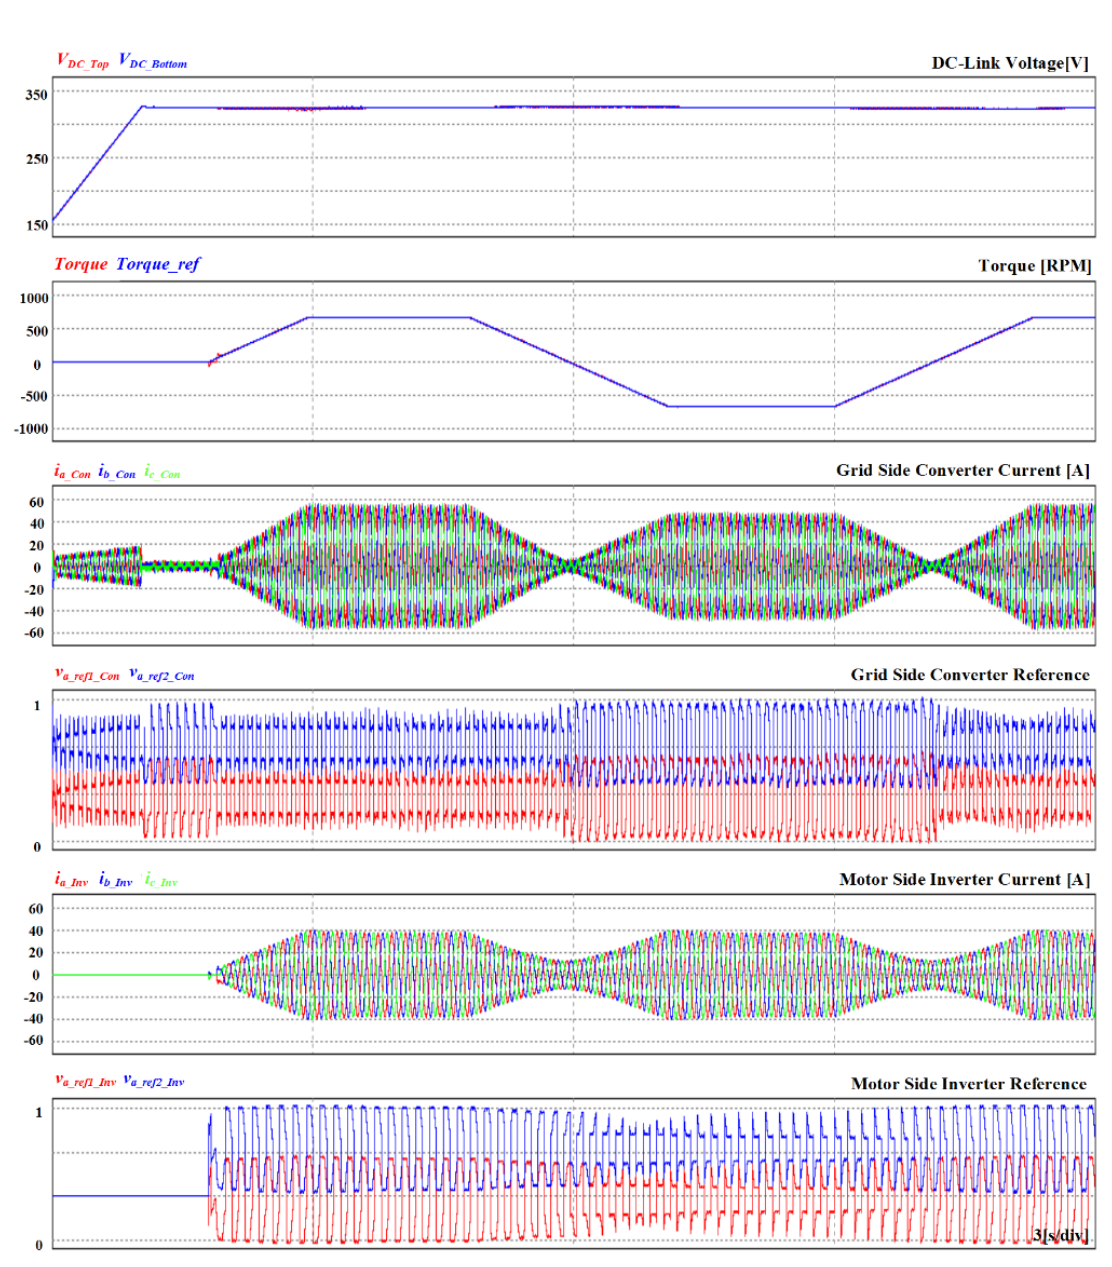
Figure 18. Simulation results of PMSG torque control using the conventional using the proposed ZDPWM method. ZDPWM